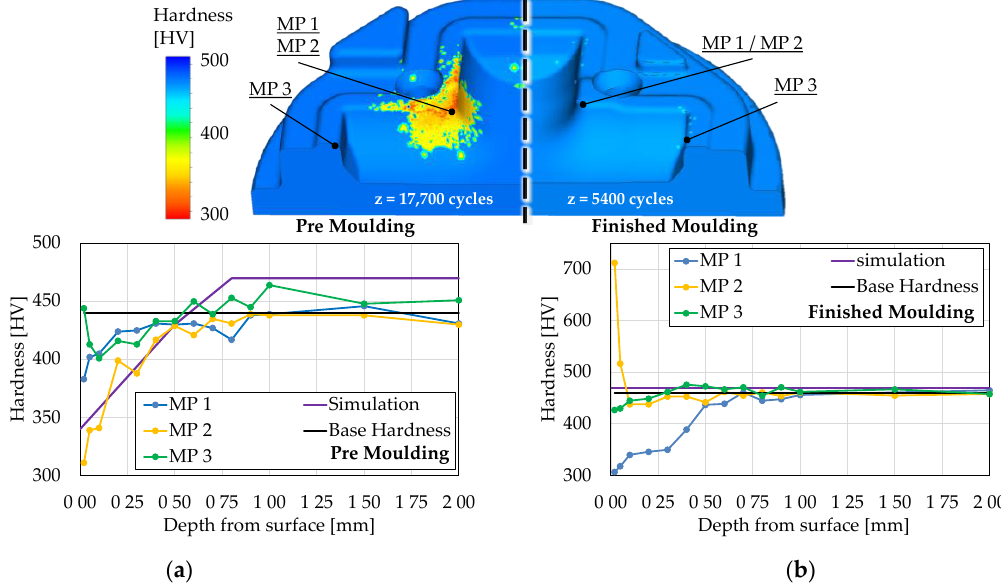
Figure 9. ( a ) Hardness calculation of the premolding and ( b ) finished molding stage compared to hardness measurements of the real tools.